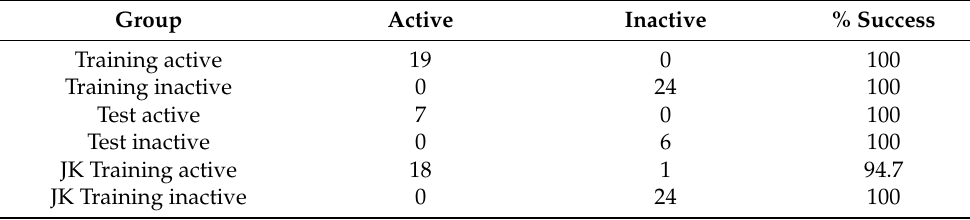
Table 2. Classification matrix for DF MRSA2 .